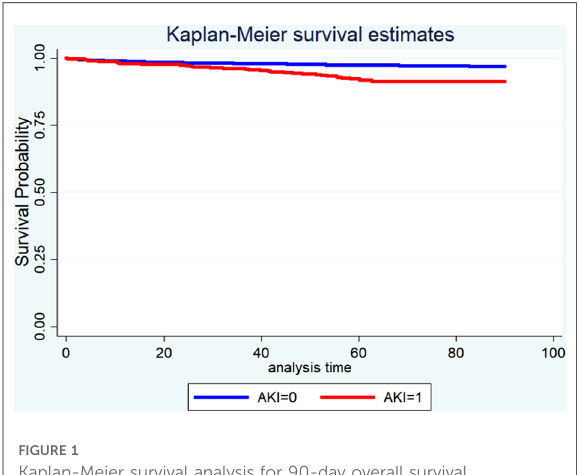
FIGURE 1 Kaplan-Meier survival analysis for 90-day overall survival.